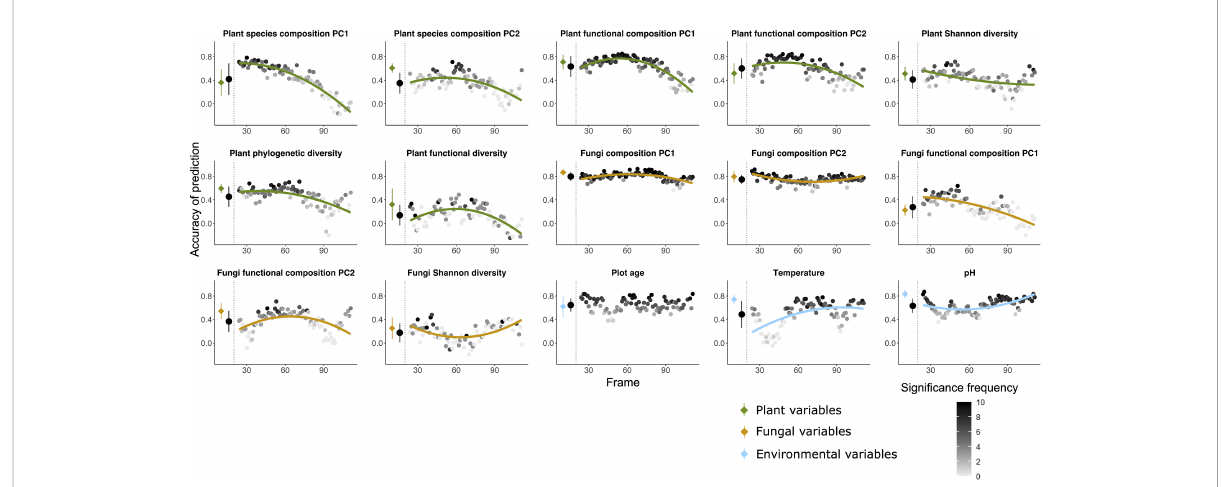
FIGURE 1 Random forest predictions using the community table of soil bacterial communities (OTU table) as explanatory variable to predict seven variables of plant (green), fi ve variables of fungi (orange) as well as three variables of environmental factors (blue) as dependent variables. The prediction was done both using all the 135 plots and using a moving frame approach. For the moving frame approach, every 45 plots were grouped into one frame and the median plot was used as identi fi er of the frame. Thus, the fi rst frame included plots 1 to 45, the second 2 to 46, and so forth. The x axis represents the median plot of every frame whose identi fi ers ranged from plot 23 to plot 113 (i.e. from young successional plots to old plots). The colored circles at the left of each plot denote the mean ± standard deviation of the accuracy of prediction (Pearson ’ s r) using the full dataset (results of 10-fold cross validation), and the black circles denote the mean ± standard deviation of the accuracy of prediction for all the frames. Each grey to black circle on the right of each plot represents the mean accuracy of prediction of each frame and the color gradient is showing how many correlations of the 10-fold cross-validation were signi fi cant with lighter colors indicating less frequent signi fi cant predictions. A quadratic or linear regression (the model with higher adjusted r 2 value) is fi t for the gradient if it is signi fi cant, showing a change of the accuracy of prediction along the successional